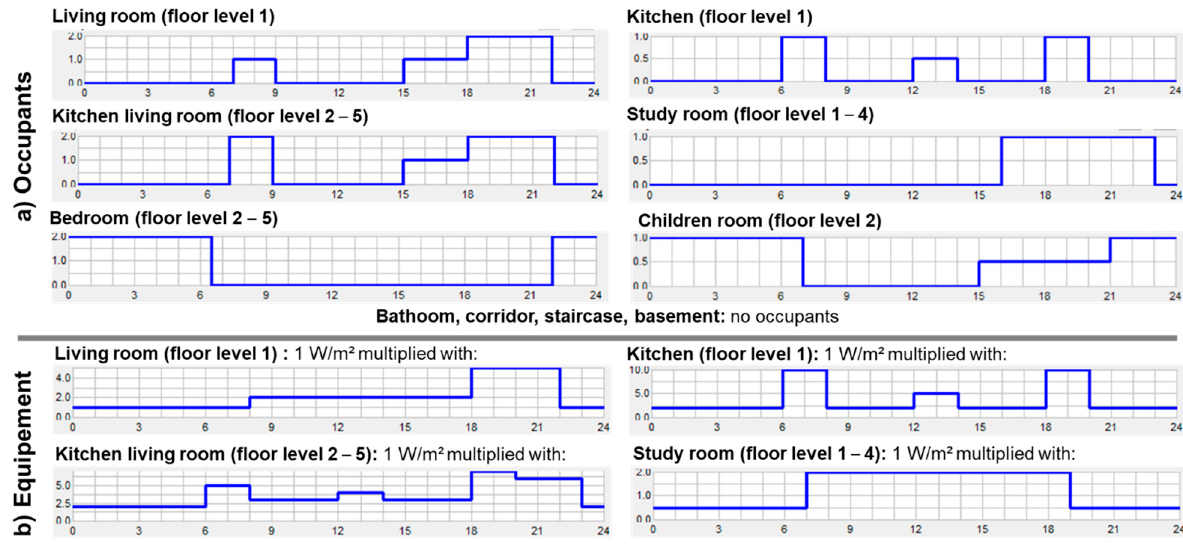
Figure A1. Timetables for ( a ) presence of occupants (number of persons) and ( b ) electrical appliances (devices and light) for the individual room use. The (dry) internal heat gain by persons is calculated in the simulation program IDA ICE using a complex model including clothing-factor, activity (metabolic equivalent MET set 1.2 for all rooms except sleeping room with 1.0) and room temperature. For reasons of simplification, no difference between weekend and week was considered. In IDA ICE an adaptive person heat gain model is implemented including activity and clothing. For the bedroom a metabolic equivalent of task (MET) according to DIN EN 13779 of 0.8 for persons in bedroom and 1.2 for persons in other rooms is assumed and operative room temperature dependent sensible and latent heat gains are calculated. The clothing factor (clo) is set 0.85 and is adaptive with operative room temperature so that persons can undress or dress by +/ − 0.25 with temperature (ANSI/ASHRAE Addendum h to ANSI/ASHRAE Standard